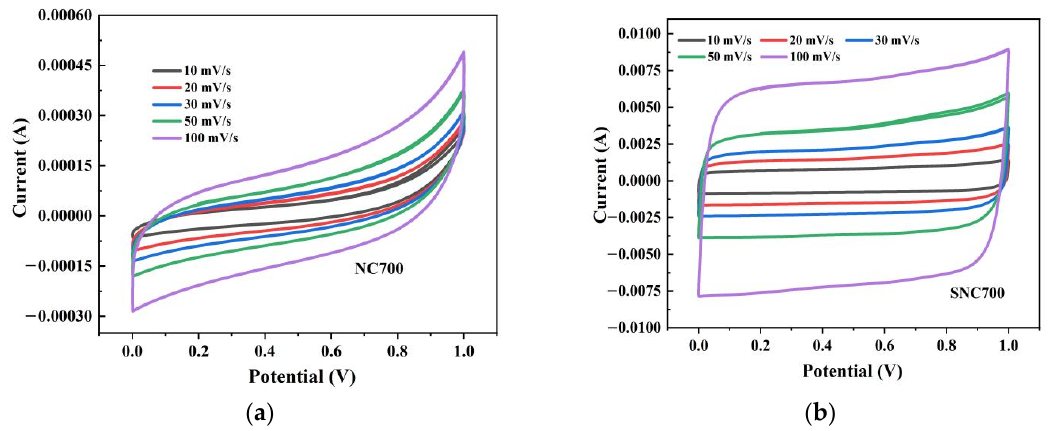
Figure 13. CV curves at different scanning rates ranging from 10 to 100 mV/s for NC700 ( a ) and SNC700 ( b ).